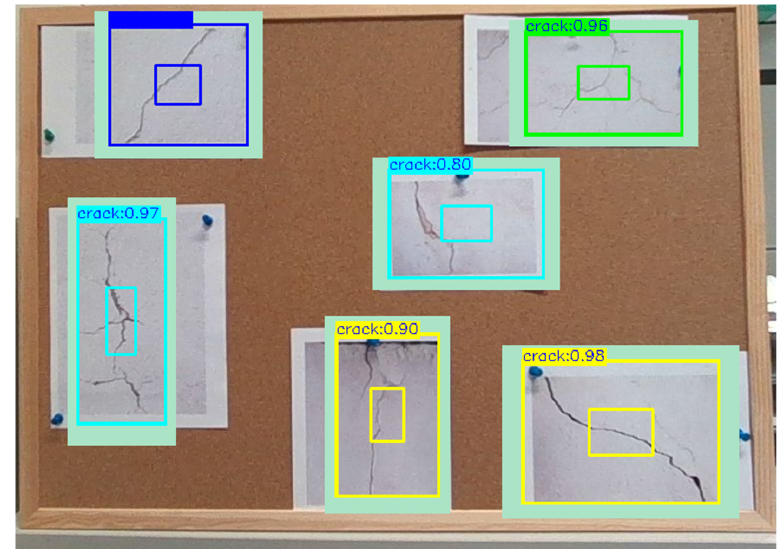
Figure 18. Multiple cracks detection results on unseen crack images.